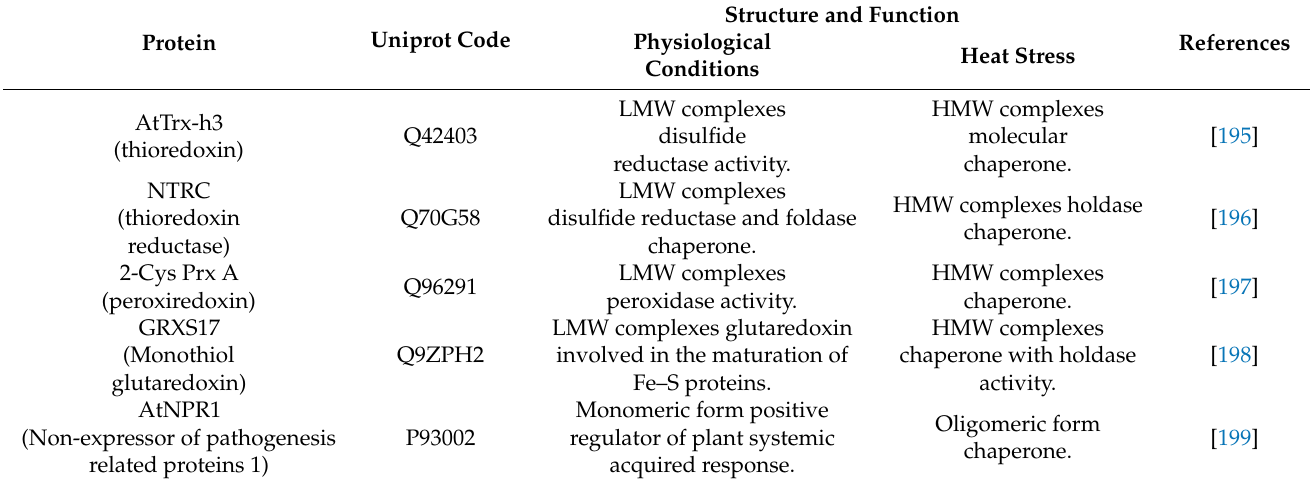
Table 1. List of redox-dependent conformational changes and functions of proteins under heat stress. Structure and